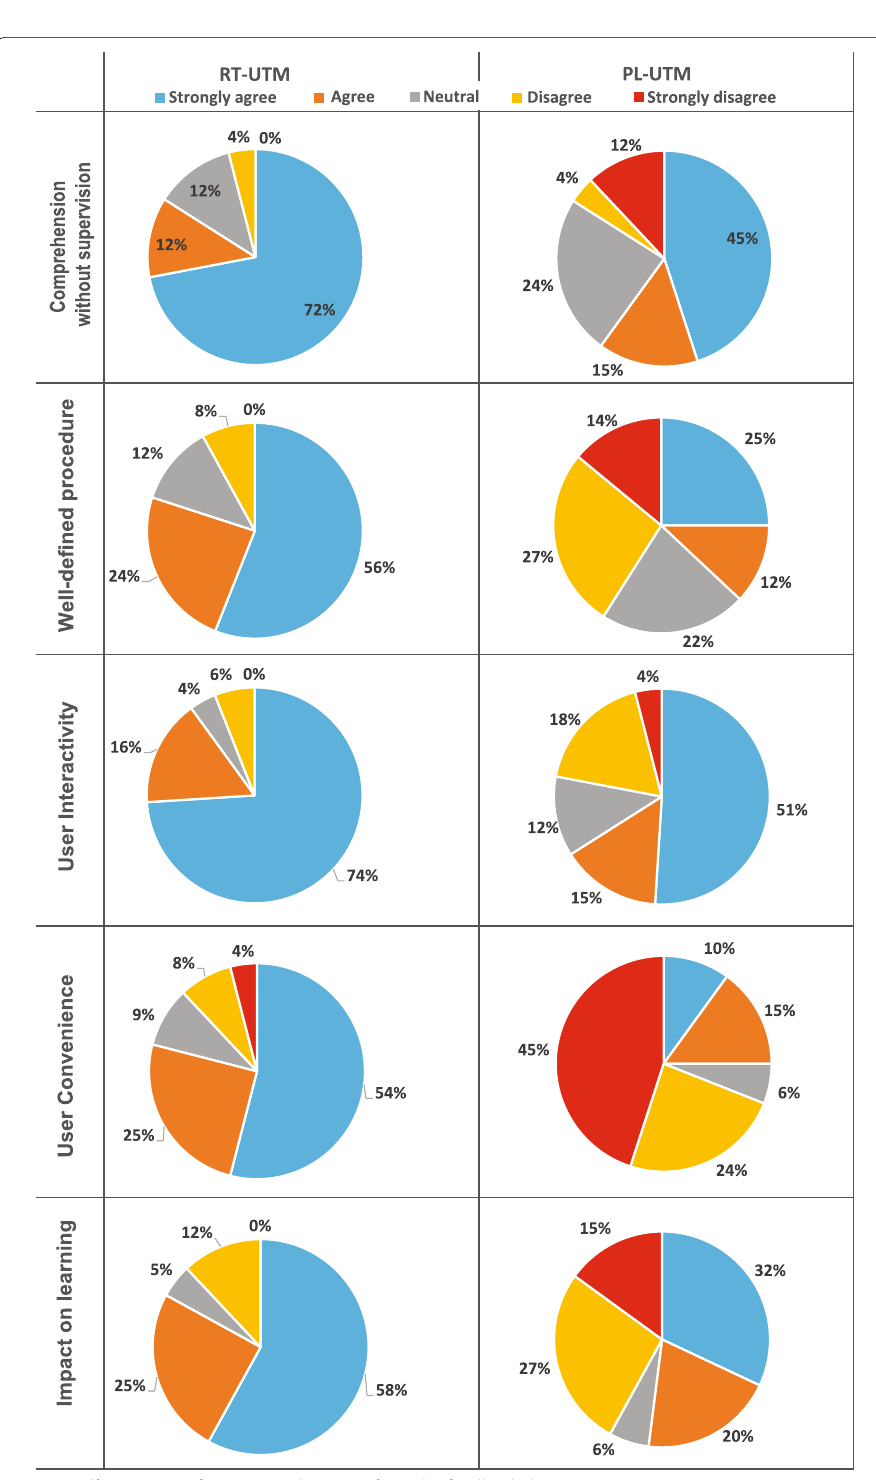
Fig. 14 Effectiveness of RT-UTM and PL-UTM from the feedback